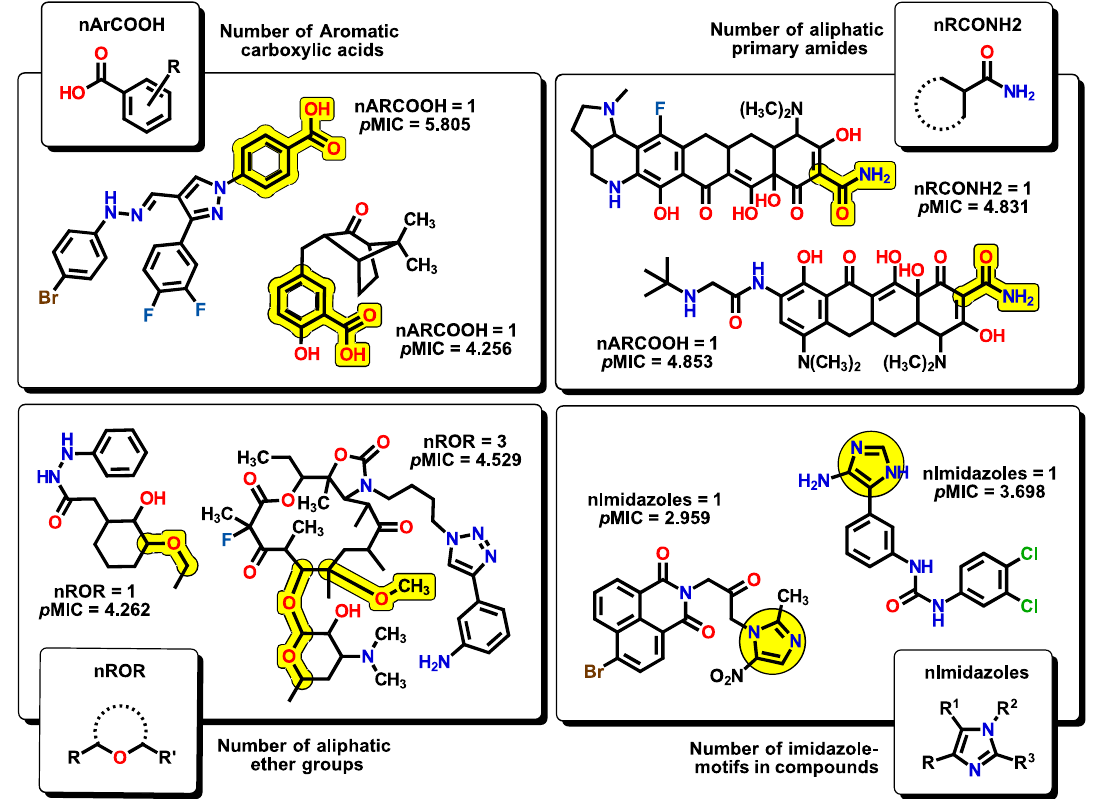
Figure 9. Functional-group count (FGC) descriptors with some representative molecules for each nArCOOH, nRCONH2, nROR, and nImidazoles. The corresponding functional groups are highlighted in yellow.